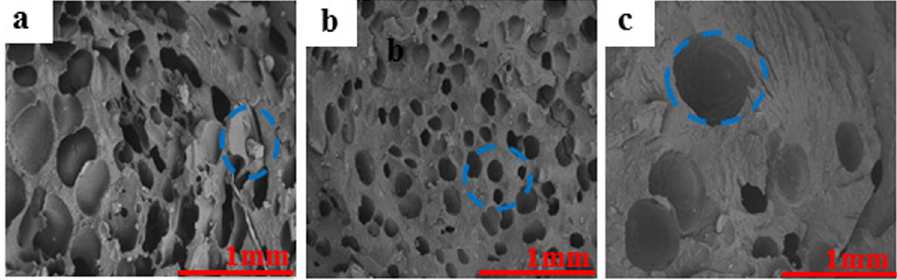
Figure A4: Cells structure of PP/MMT foams composites and cells size distribution: ( a ) PP/SB, ( b ) PP/PA/EP@SB, ( c )